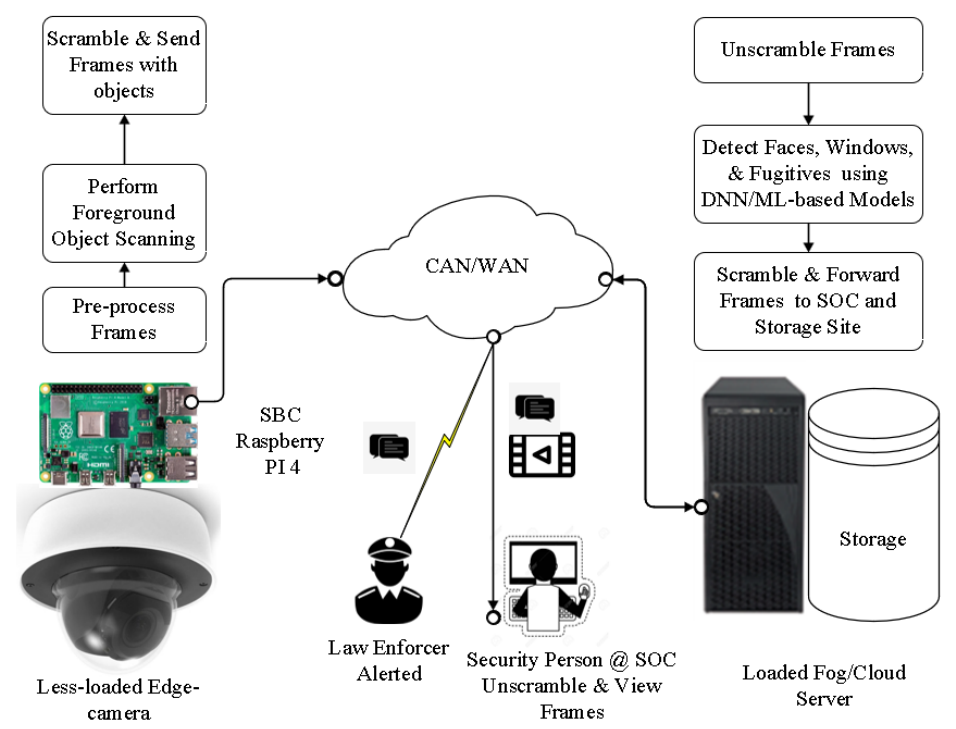
Figure 1. Hybrid Architecture of the PriSE system: The edge camera creates frames, performs foreground object scanning and encrypts frames. The cloud/fog server deciphers frames, detects and masks windows and faces, and performs fugitive face